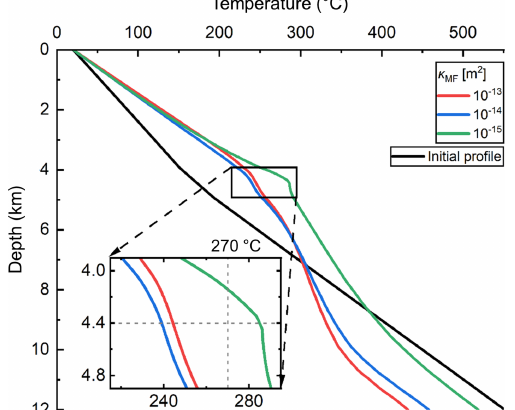
Figure 7. Effects of the main fault permeability ( κ MF ) on the temperature-depth profiles. The κ MF = 10 − 13 m 2 case represents the reference